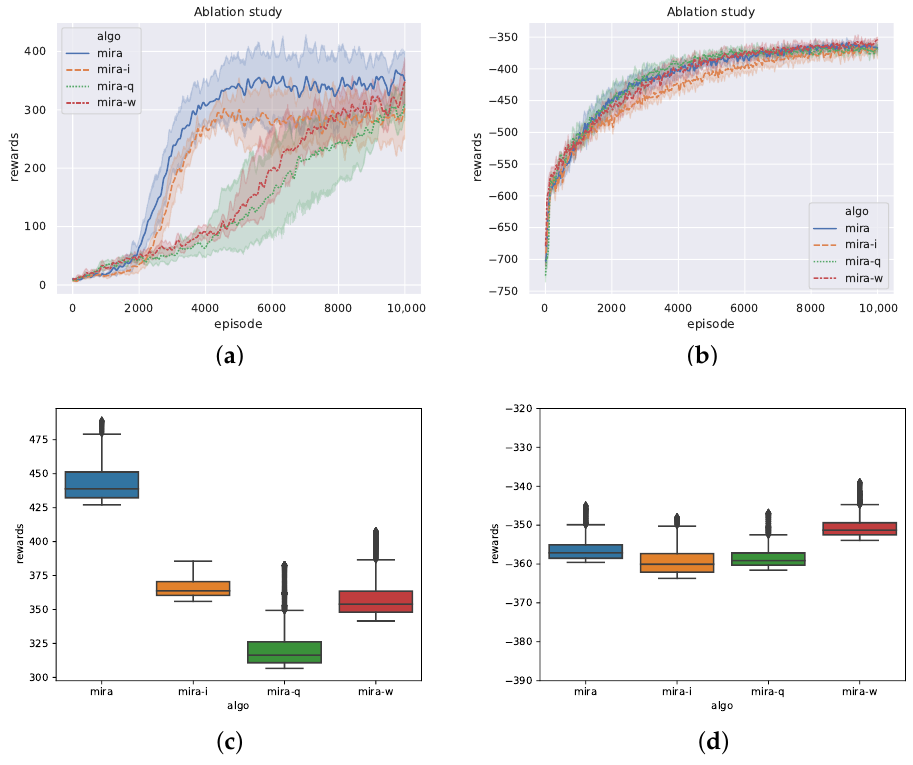
Figure 6. Performance of ablation versions. ( a ) Training curves on predator-prey. ( b ) Training curves on Cooperative Navigation. ( c ) Ending rewards on predator-prey. ( d ) Ending rewards on Cooperative Navigation.